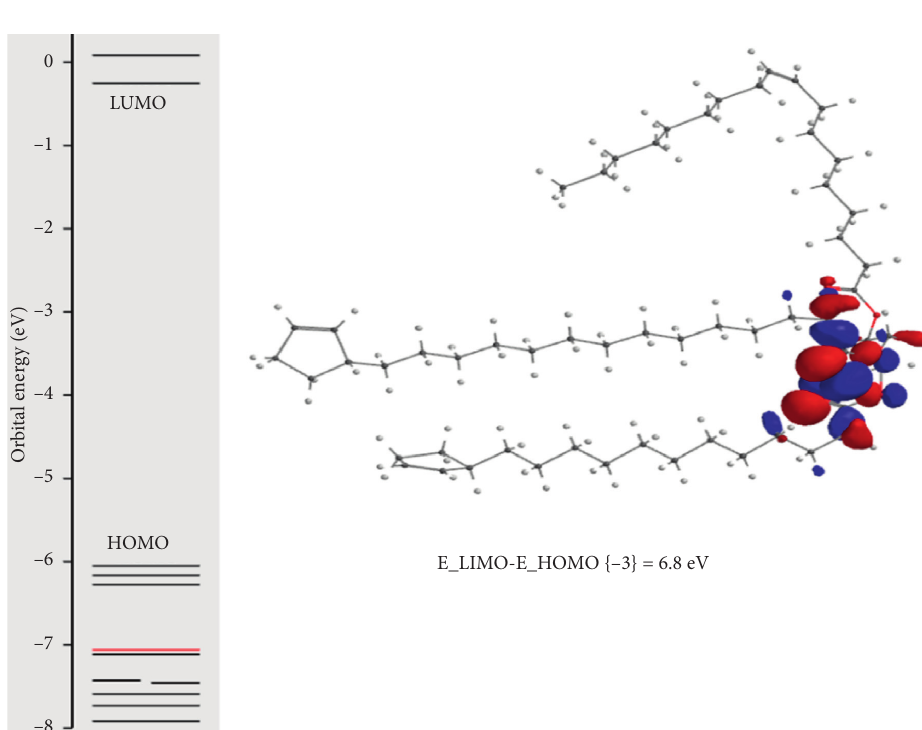
Figure 12: HOMO-LUMO map of the typical molecule of chaulmoogra